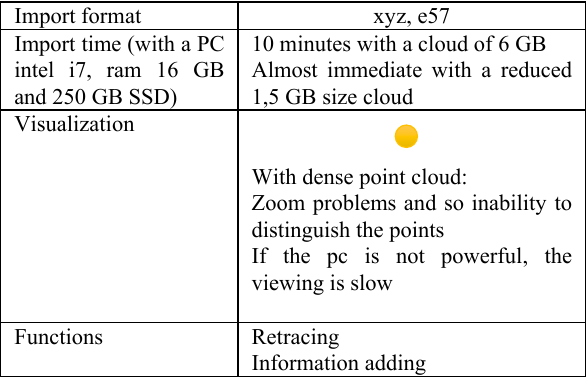
Table 3. Summary of point cloud’s import process in Archicad.